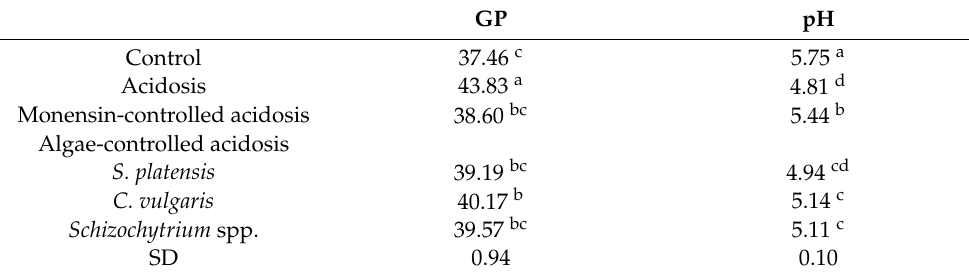
Table 4. Effects of microalgae on acidosis in a test for carbohydrate